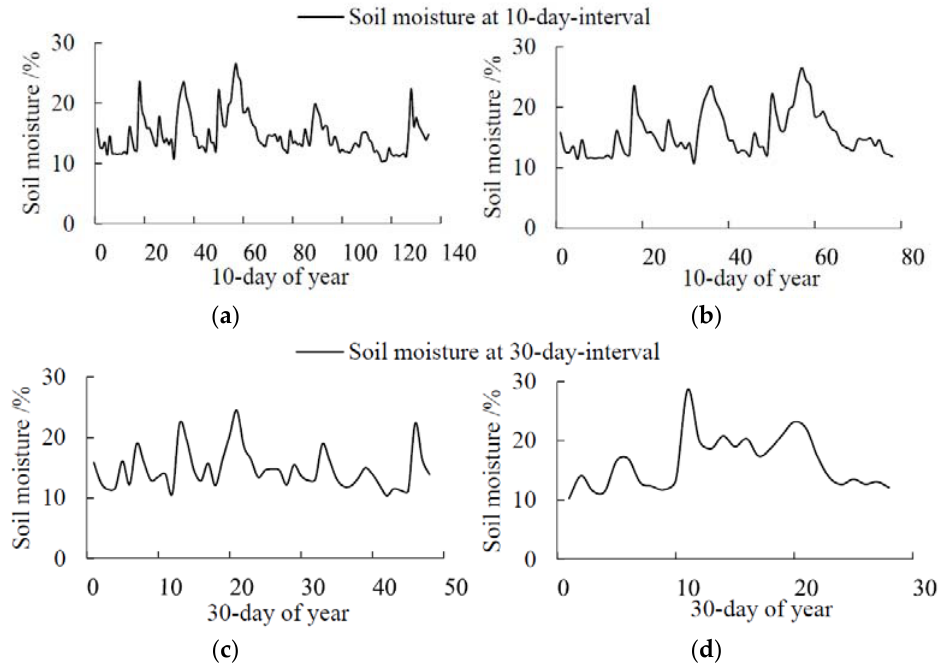
Figure 12. Soil moisture at different sampling intervals. ( a ) 10 ‐ day sampling interval in the calibration period; ( b ) 10 ‐ day sampling interval in the validation period; ( c ) 30 ‐ day sampling interval in the calibration period; ( d ) 30 ‐ day sampling interval in the validation period.